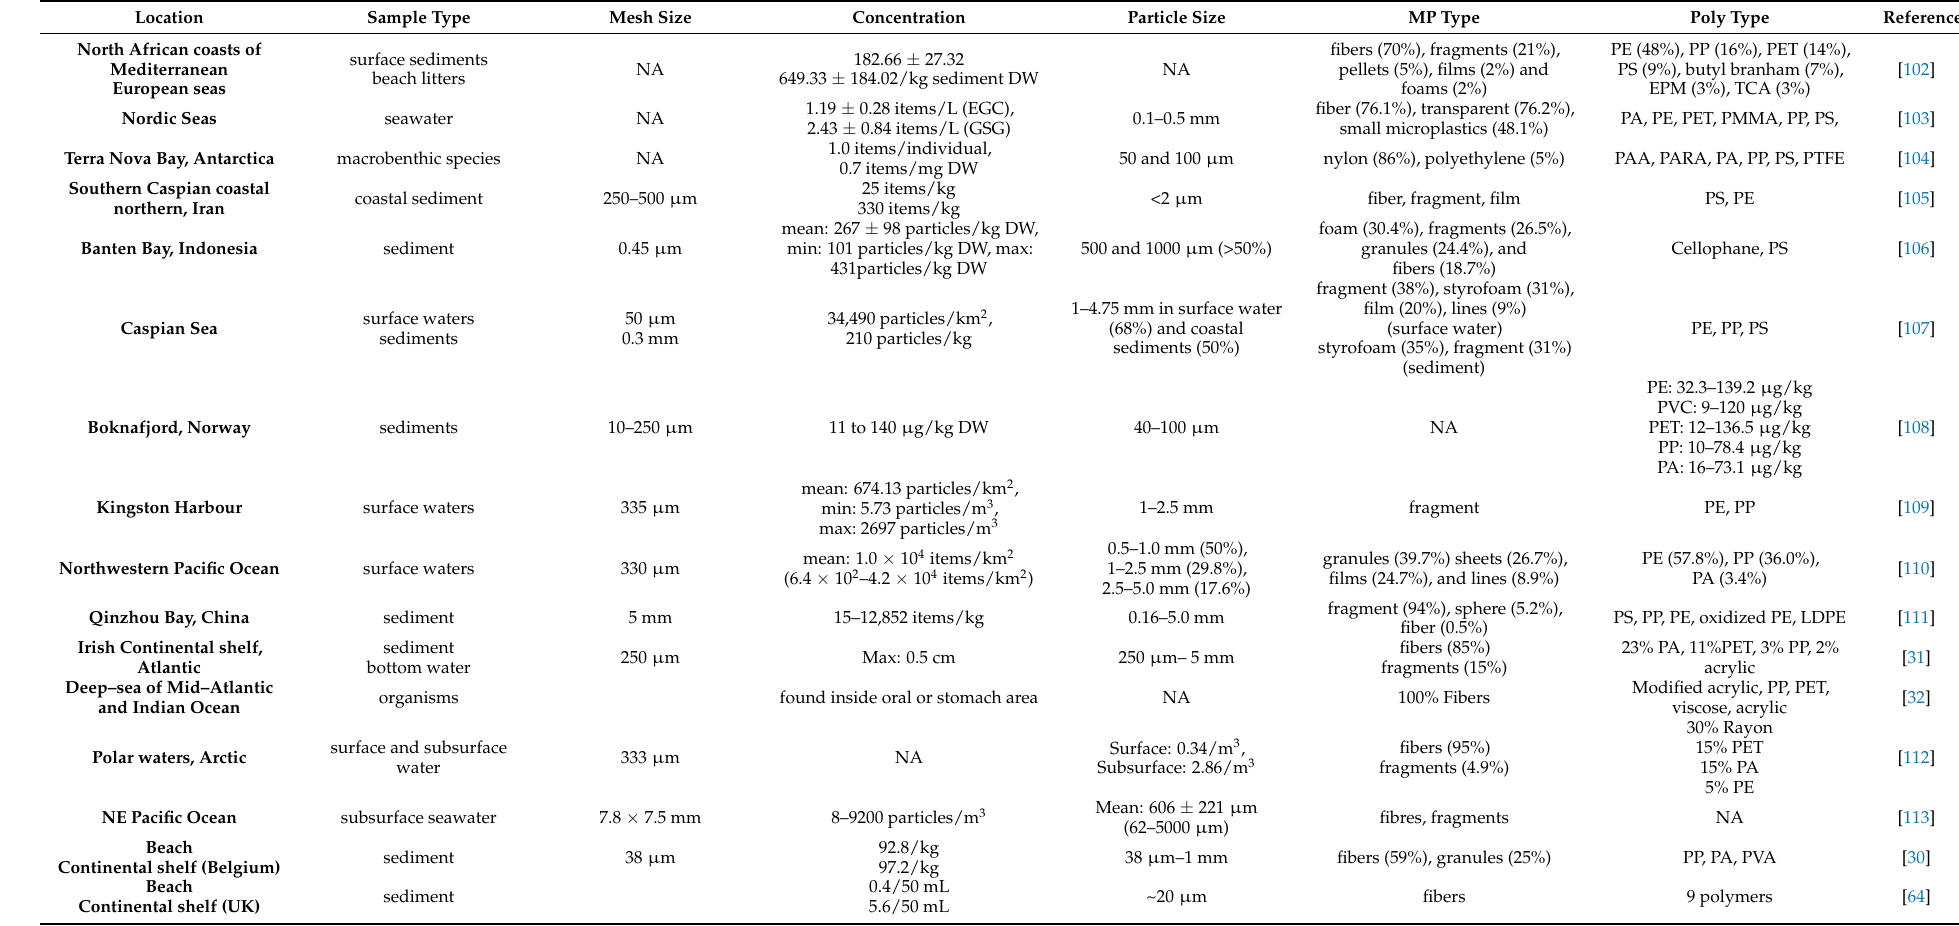
Table 1. The characterization of MPs in marine